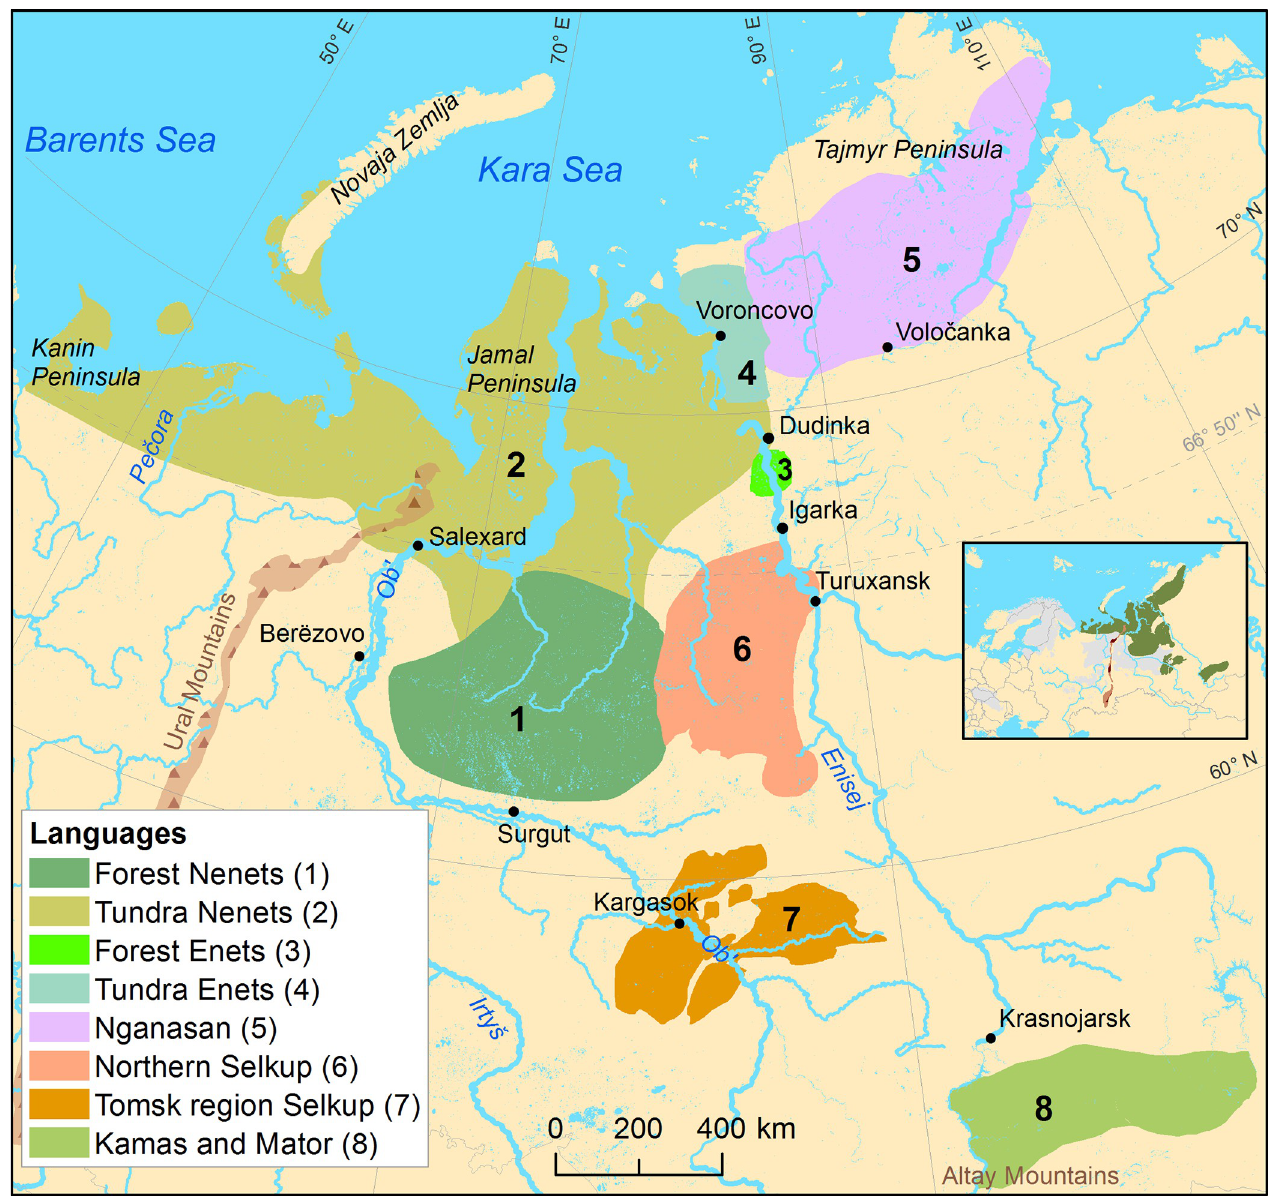
Fig 4. Samoyedic languages at the beginning of the 20th century. Languages are presented without overlapping areas. Original sources: Soviet Census of 1926 [54], Popov [55], Dolgikh [38], Dolgikh & Fajnberg [56], Dolgikh [57], Verbov [58], Gru¨nthal & Salminen [33], Helimski [59], Tuchkova et al. [60],